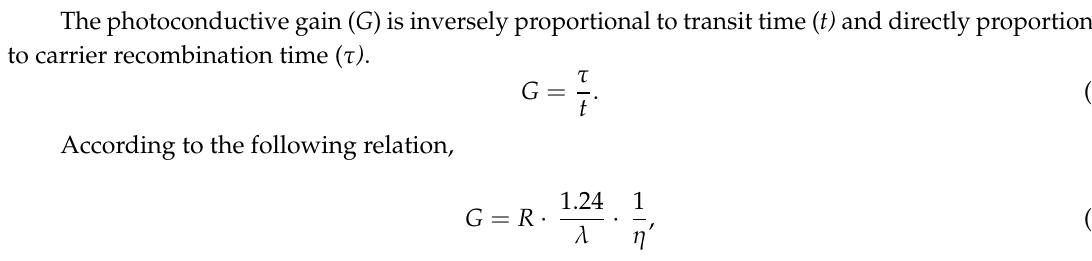
Figure 10. Responsivity as a function of wavelength for ( a ) S1; ( b ) S2; and ( c ) S3.